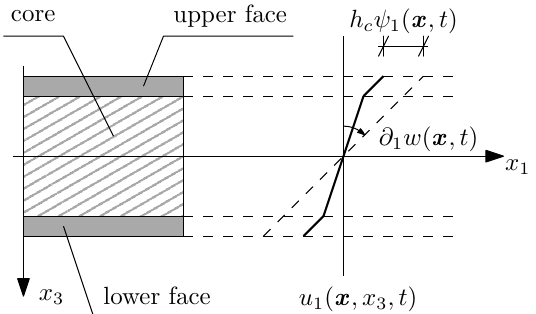
Figure 3. In-plane displacement hypothesis according to the broken line